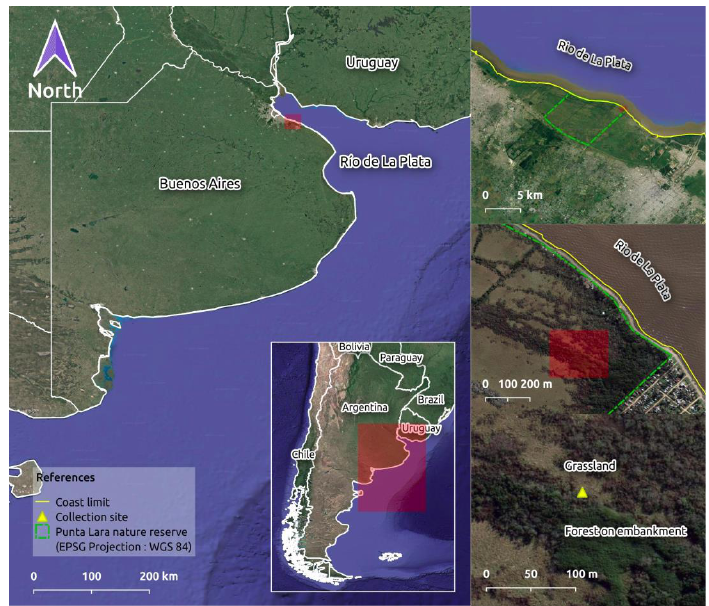
Figure 1. Geographic location of the collection site in the Punta Lara Natural Reserve (PLNR), located on the coast of the Río de La Plata river (Buenos Aires, Argentina). on the coast of the R í o de La Plata river (Buenos Aires,